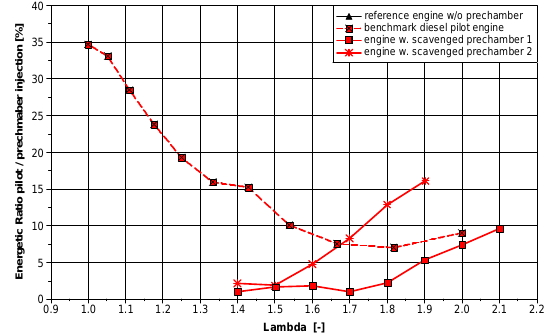
Fig. 12. Energy fraction for Diesel pilot or prechamber fueling for operat- ing point 1 (1400 rpm/50 Nm/bmep 3.2 bar)